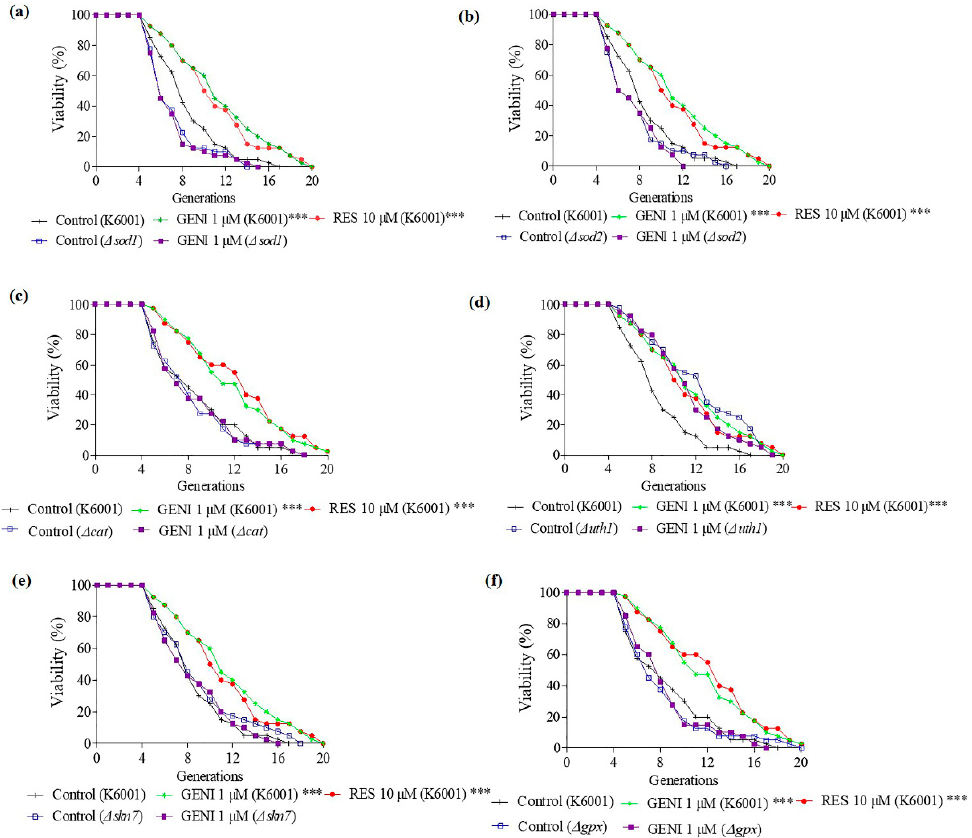
Figure 5. Effect of GENI on the replicative lifespan of K6001 sod1 ( a ), sod2 ( b ), cat ( c ), uth1 ( d ), skn7 ( e ), and gpx ( f ) yeast mutants. Experiments were repeated thrice, and the data are presented as means ± SEM. *** p < 0.001 represent significant difference compared with the control group.